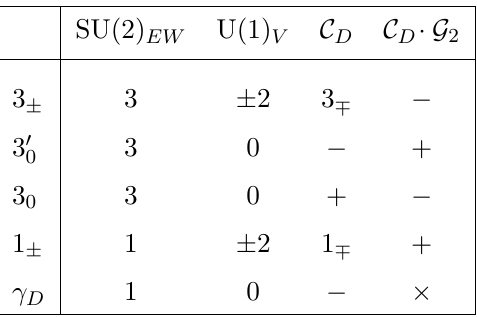
Table 3 . Transformation properties of the NGBs and of the dark photon under the symmetries of the